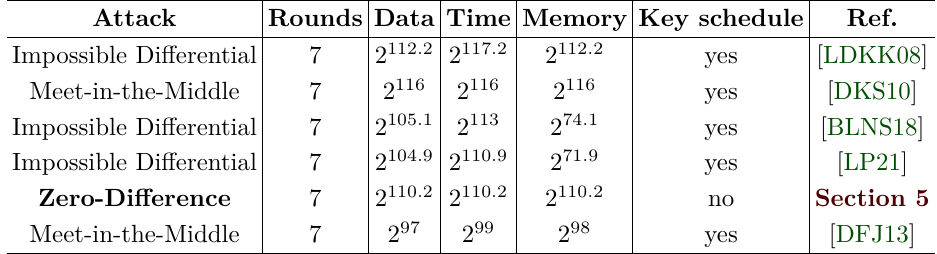
Table 1: Current best cryptanalysis of 7-round AES-128 in the secret-key model. Attack Rounds Data Time Memory Key schedule Ref. Impossible Differential 7 2 112 . 2 2 117 . 2 2 112 . 2